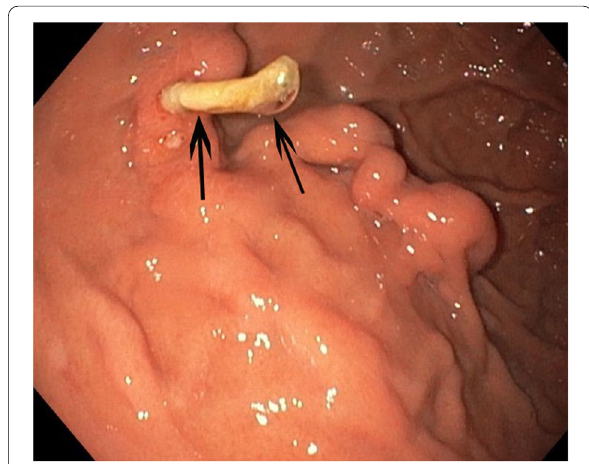
Fig. 3 Follow‑up gastroscopy one month after glue‑embolization shows part of the glue‑cast (arrows) protruding into the gastric lumen. No other mucosal lesions could be